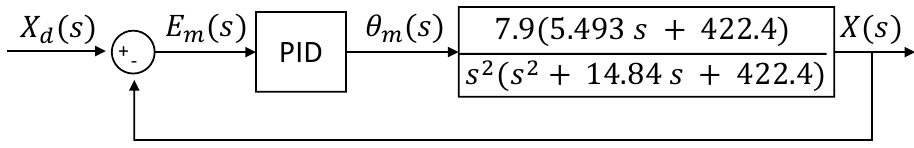
Figure 20. Reduced master loop block diagram.